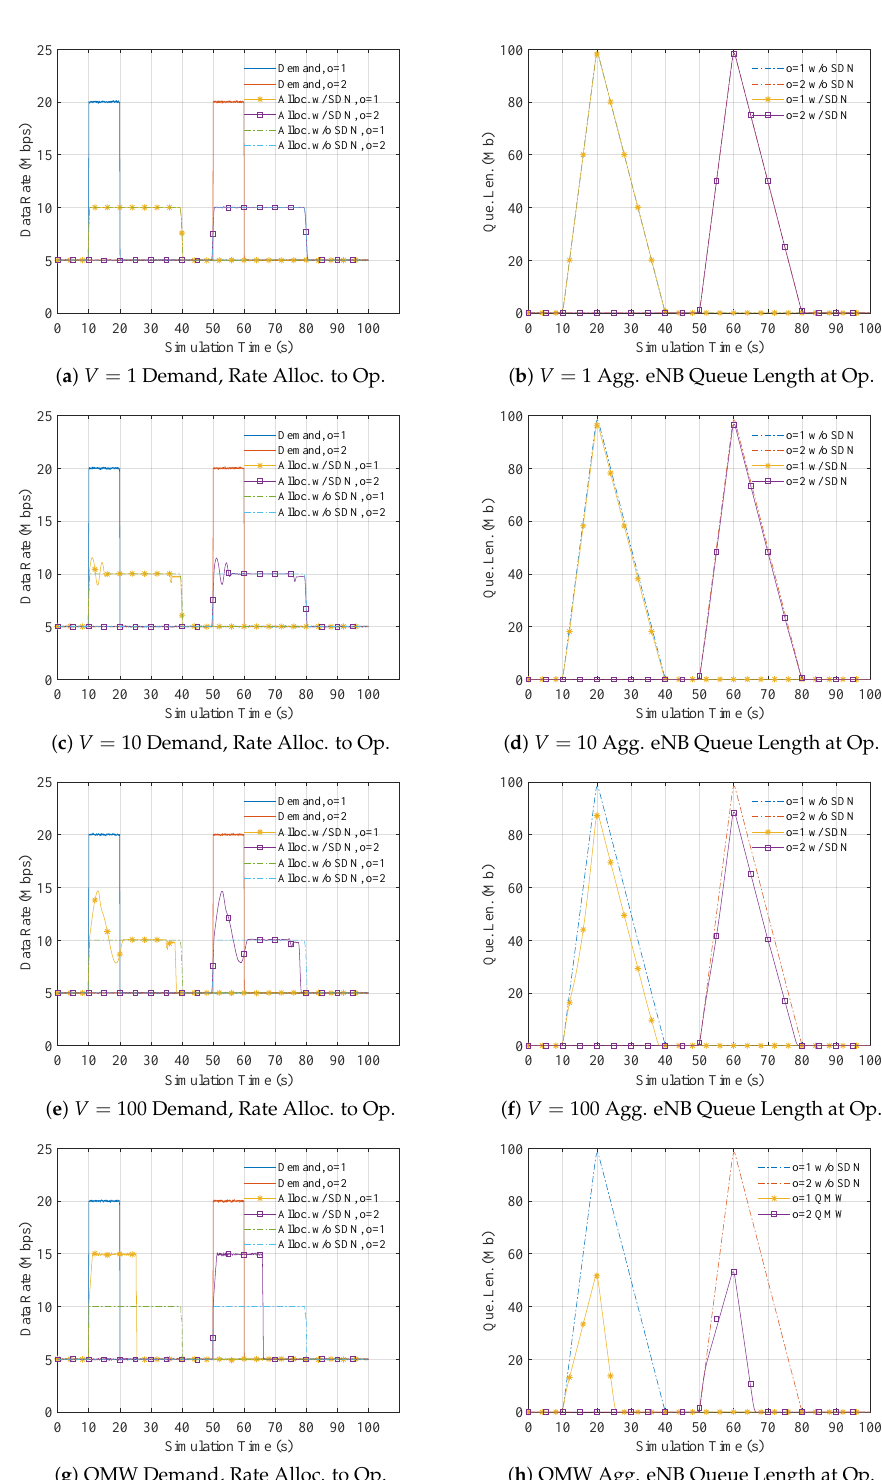
Figure 4. Upstream backhaul bitrate allocations and eNB queue lengths when demand peaks for operators 1 and 2 are spaced apart: Increasing the “flexibility parameter” V , see Equation (7), increases the sharing of backhaul capacity among the two operators and decreases the queue lengths compared to the benchmark without SDN orchestrated backhaul resource sharing; for V = 1000, please refer to Figure 3c,d. The QMW case corresponds to the SDN-based optimization without a long-term